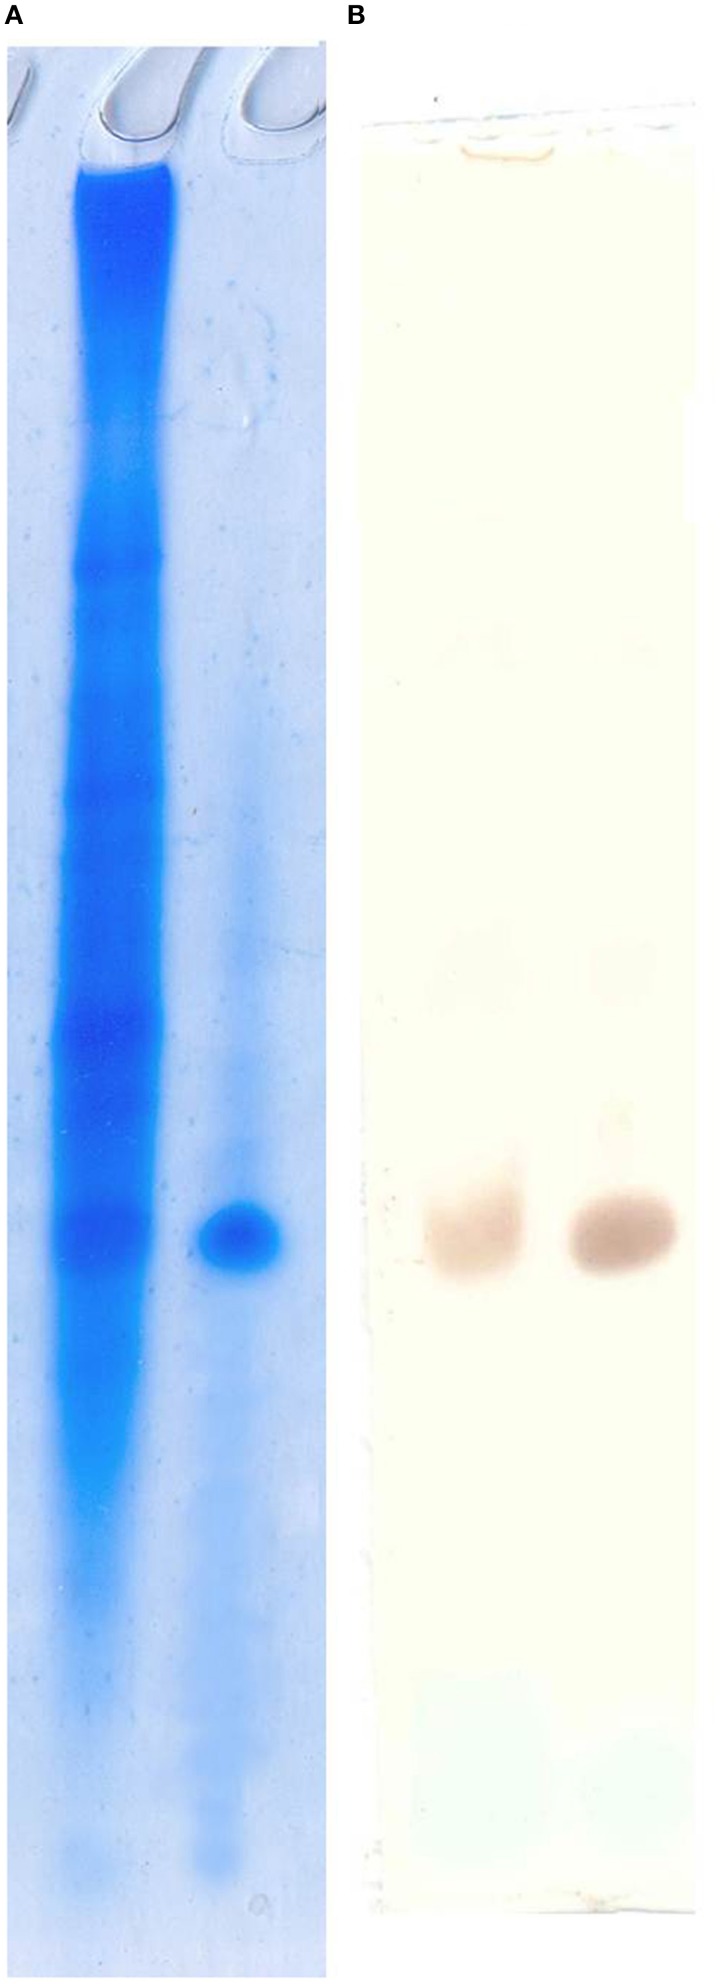
Polyclonal antibody specificity testing by Western blot. Acidic urea PAAG (A) and pAB staining visualized by DAB (B). Left line, crude extract; right line, synthetic arenicin-1.